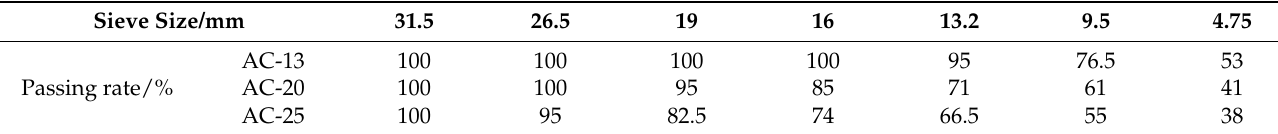
Table 3. Mesoscopic parameters of the balls and parallel-bond